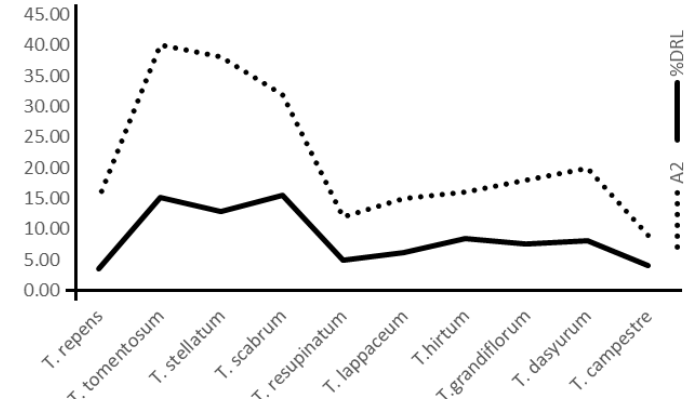
Fig. 4. Interchromosome asymmetry index and difference of relative length trend in different Trifolium